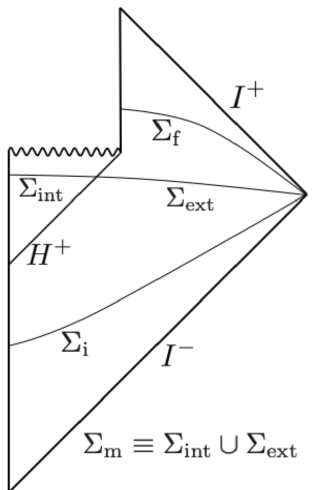
Figure 1. The Penrose diagram describing an evaporating